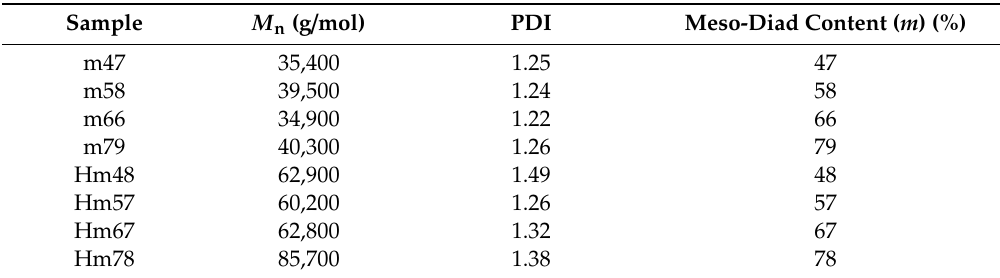
Table 1. Characteristics of poly ( N -isopropylacrylamides) (PNIPAM) Samples.